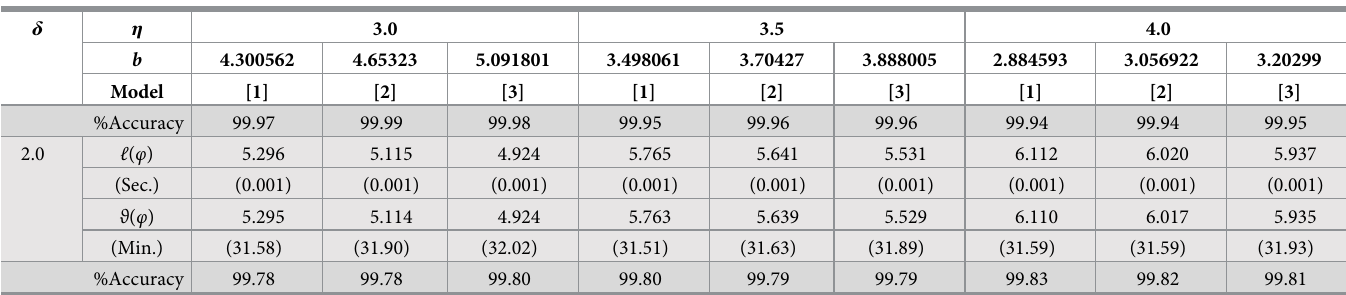
The results are expressed as percentage accuracy with computational times in parentheses for the analytical IE method (seconds) and the numerical IE method (minutes).